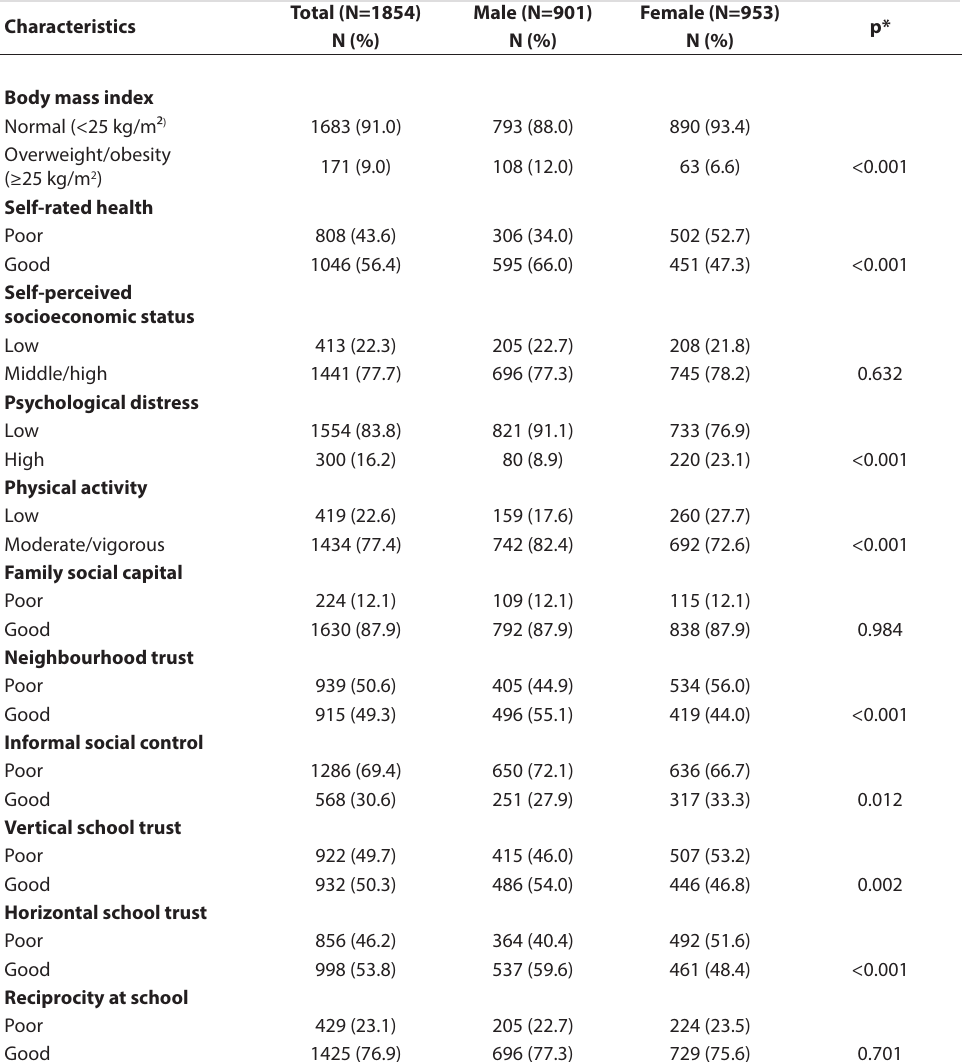
TABLE 1 Characteristics of the Study